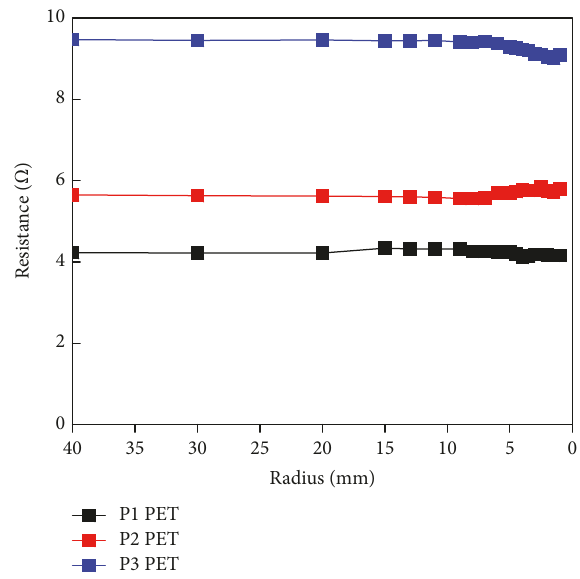
Figure 10: Electrical resistance versus radius of curvature plot for inner bending